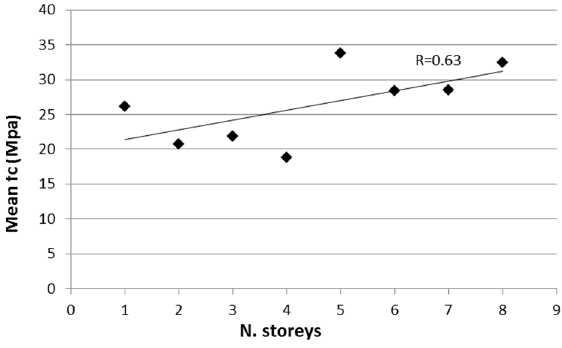
Figure 3. Mean concrete strength as a function of the number of storeys.